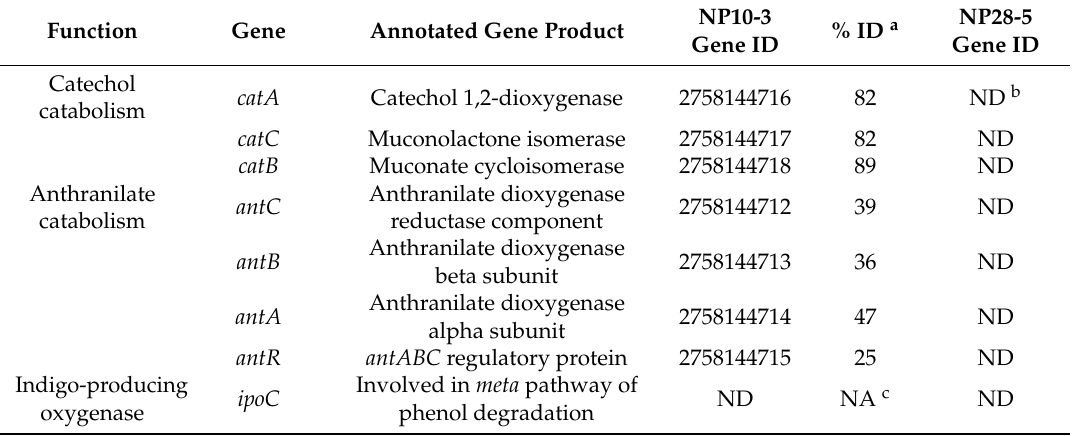
Table 3. Genes located within the woody host and Pseudomonas species (WHOP) region identified in P. syringae